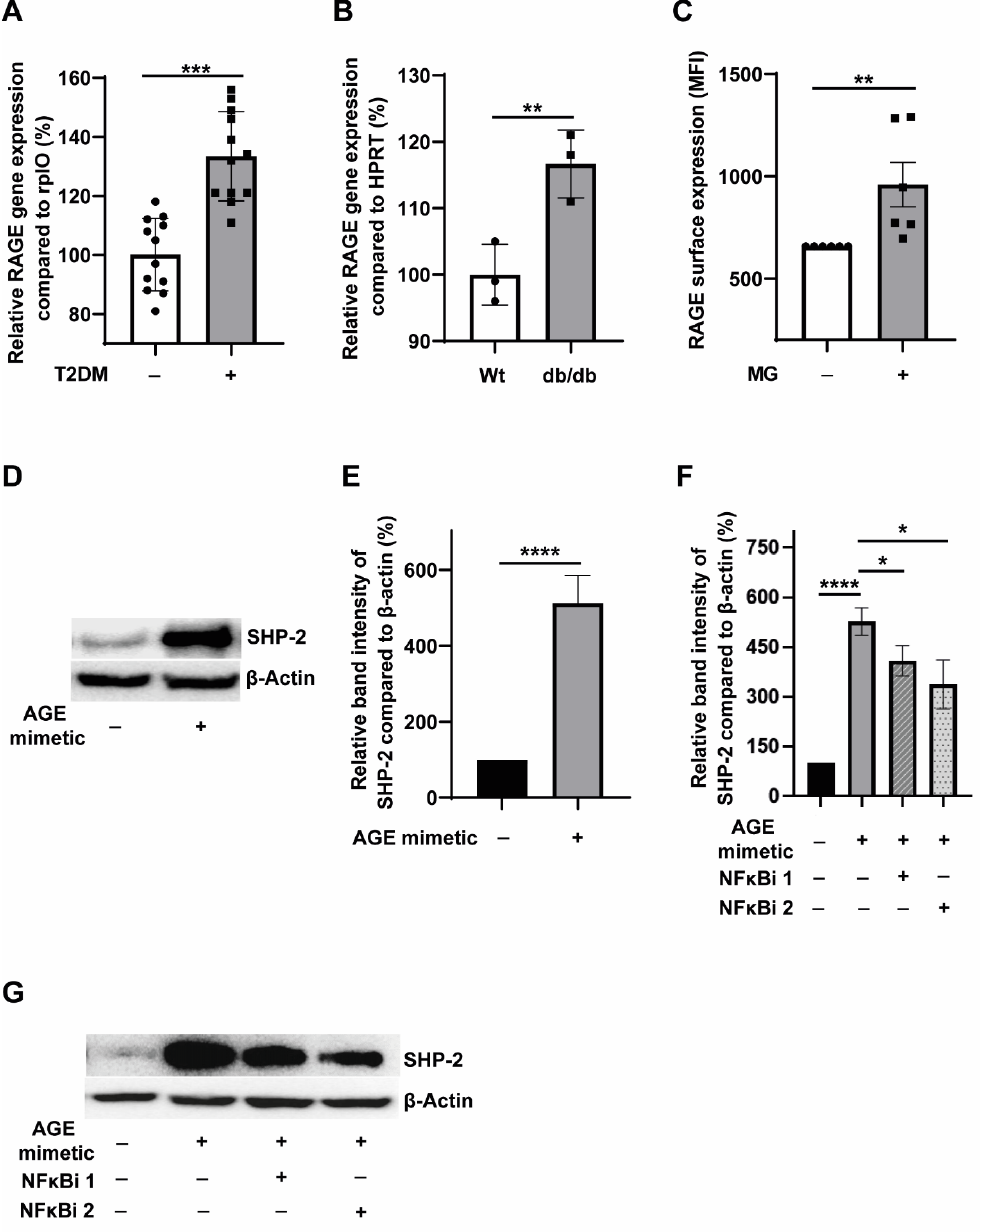
Figure 3. Hyperglycemia induces RAGE expression in monocytes and AGE-RAGE signaling po- tentiates SHP-2 expression through the NFkB pathway . ( A ) Relative expression of RAGE mRNA compared to rplO. Primary monocytes isolated from the peripheral blood of non-T2DM ( n = 12) and T2DM ( n = 12) were used for the analysis. ( B ) Relative expression of RAGE mRNA compared to HRPT. Primary murine monocytes isolated from the bone marrow of wildtype ( n = 3) and db/db ( n = 3) mice were used for the analysis. ( C ) FACS analysis of the surface expression of RAGE. Exposure of monocytes with 300 µ M MG for 24 h. n = 6. ( D ) Representative blots and ( E ) corresponding quantification. Expression of SHP-2 in relation to ß-actin. Exposure of monocytes without (black bar) or with (grey bar) 150 µ g/mL AGE-BSA for 24 h. n = 11. ( F ) Corresponding quantification and ( G ) representative blots. Expression of SHP-2 in relation to ß-actin. Exposure of monocytes without (black bar) or with (grey bars) 150 µ g/mL AGE-BSA for 24 h. Quantification of monocytes additionally treated with NFkB-inhibitor is shown as striped (5 µ M Activation Inhibitor II, NF κ Bi 2, JSH23) and dotted bar (1 µ M NF-kB Activation Inhibitor, NF κ Bi 1). n = 6. * p < 0,05, ** p < 0.01, *** p < 0.001, **** p <